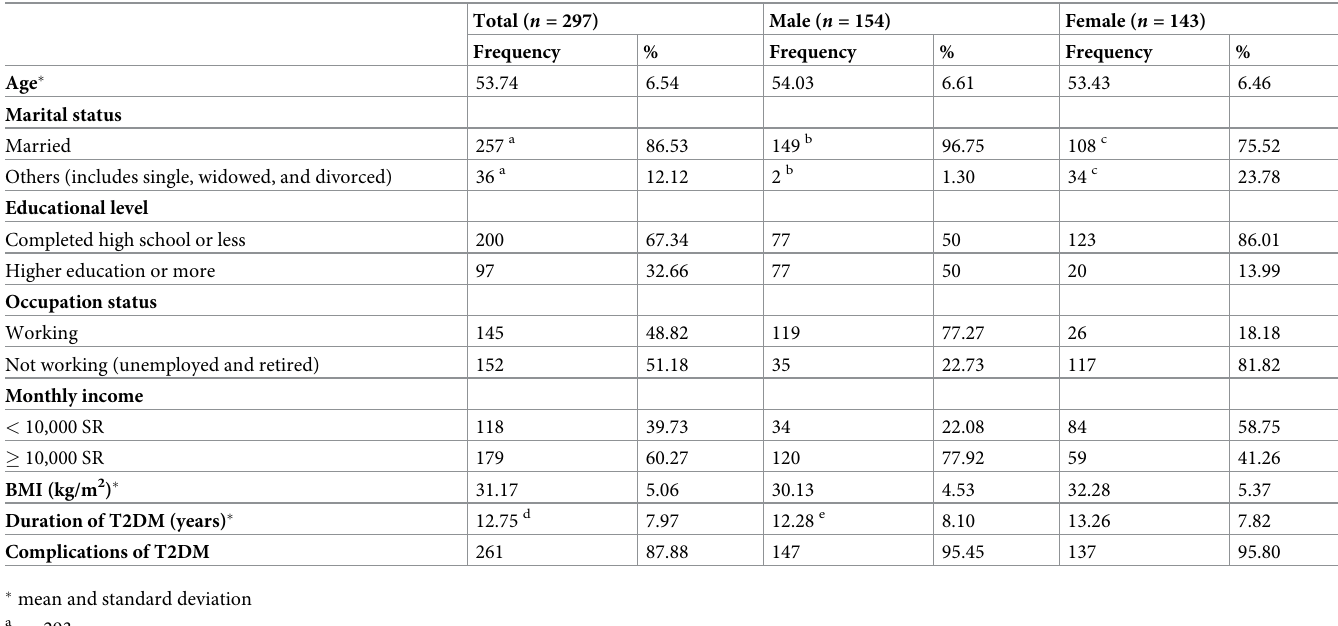
Table 1. Sociodemographic characteristics of the study population stratified by sex.